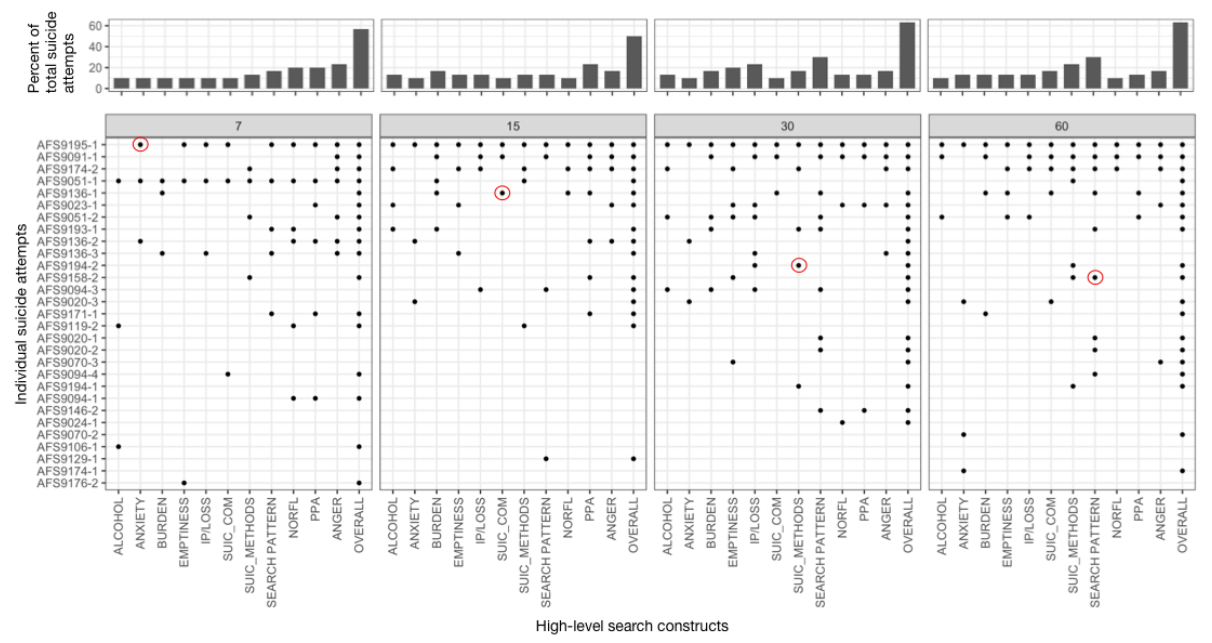
Figure 3. Summary of individualized association analysis for 11 high-level search constructs over 4 suicide attempt–proximal periods: (a) 7, (b) 15 (c) 30, and (d) 60 days.